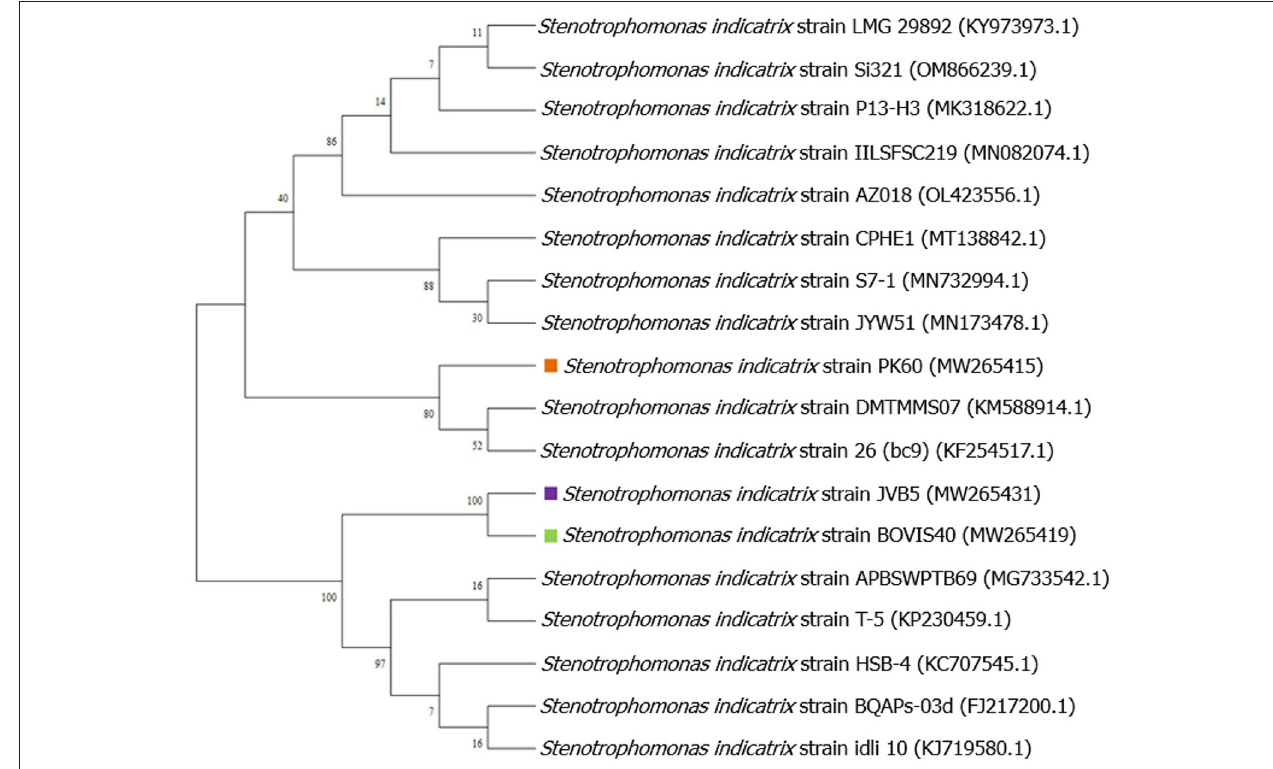
FIGURE 1 | Evolutionary relationships of taxa tree based on partial 16S rRNA sequences using maximum likelihood-based on the Tamura-Nei model showing relationships between the endophytic Stenotrophomonas species and its closely related strains from NCBI